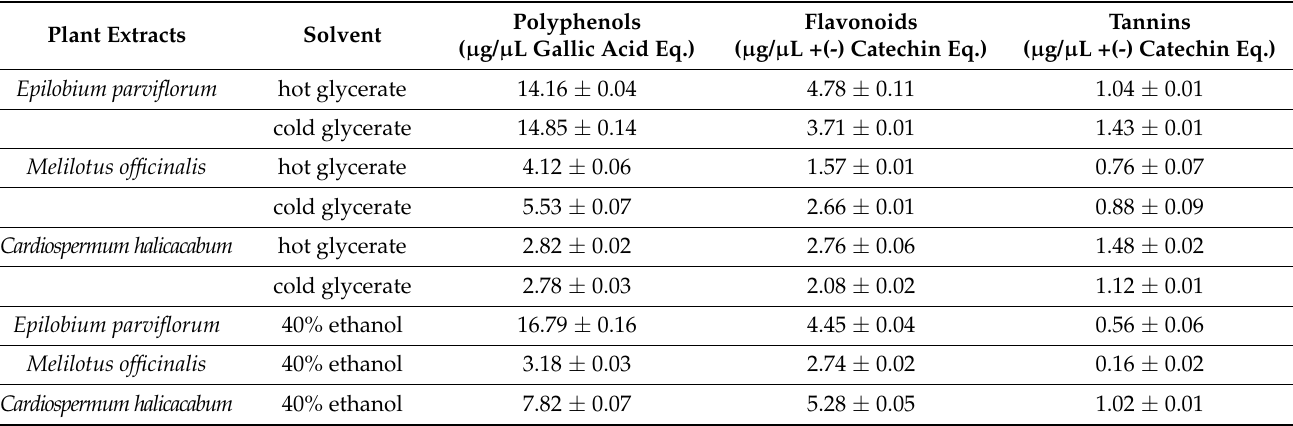
Table 1. Polyphenols, flavonoids, and tannins content of the plant extract Epilobium parviflorum , Melilotus officinalis, and Cardiospermum halicacabum were prepared in hot and cold glycerate and 40% ethanol. Plant